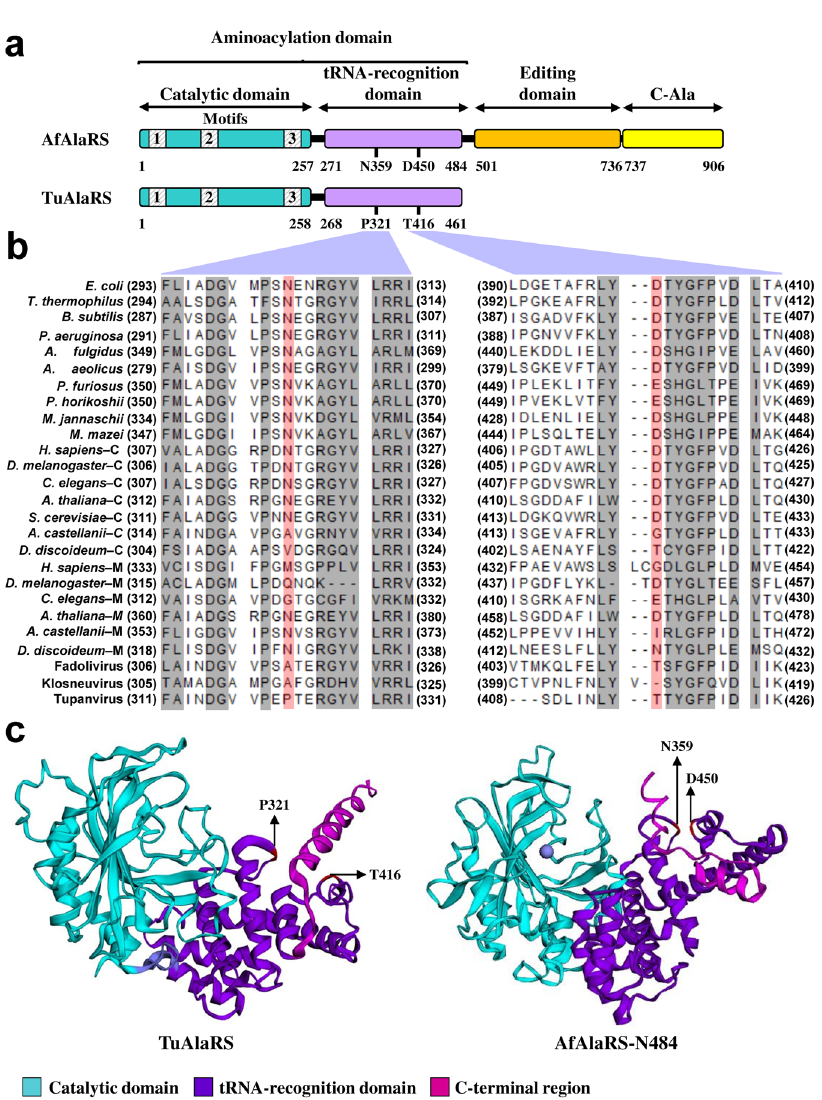
Fig. 1 Domain organization of TuAlaRS. a Schematic representation of TuAlaRS and AfAlaRS. The relative positions of the four domains are marked. b Alignment of the sequences fl anking the G3:U70-recognition amino acid residues N and D (highlighted in red) in the tRNA-recognition domain. c Structural modeling of TuAlaRS in comparison with AfAlaRS-N484. The catalytic and tRNA-recognition domains were colored in light-blue and purple, respectively. The C-terminal helix of the tRNA-recognition domain was highlighted in